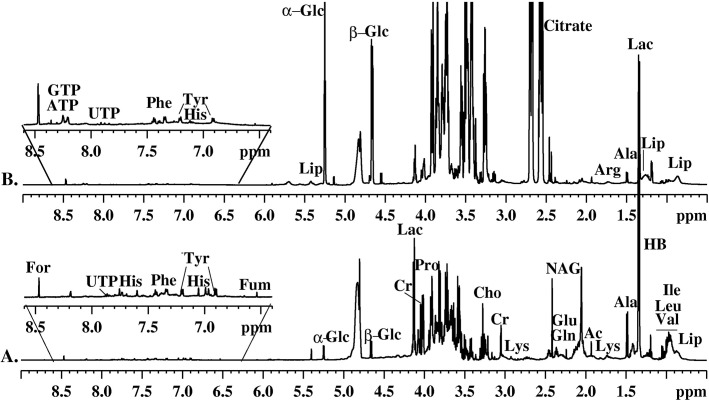
MHz 1H-NMR spectra of FBS_I and FBS_II and hUCBP.Average 600 MHz 1H-NMR spectra (A) of FBS_I, and FBS_II and (B) hUCBP samples.